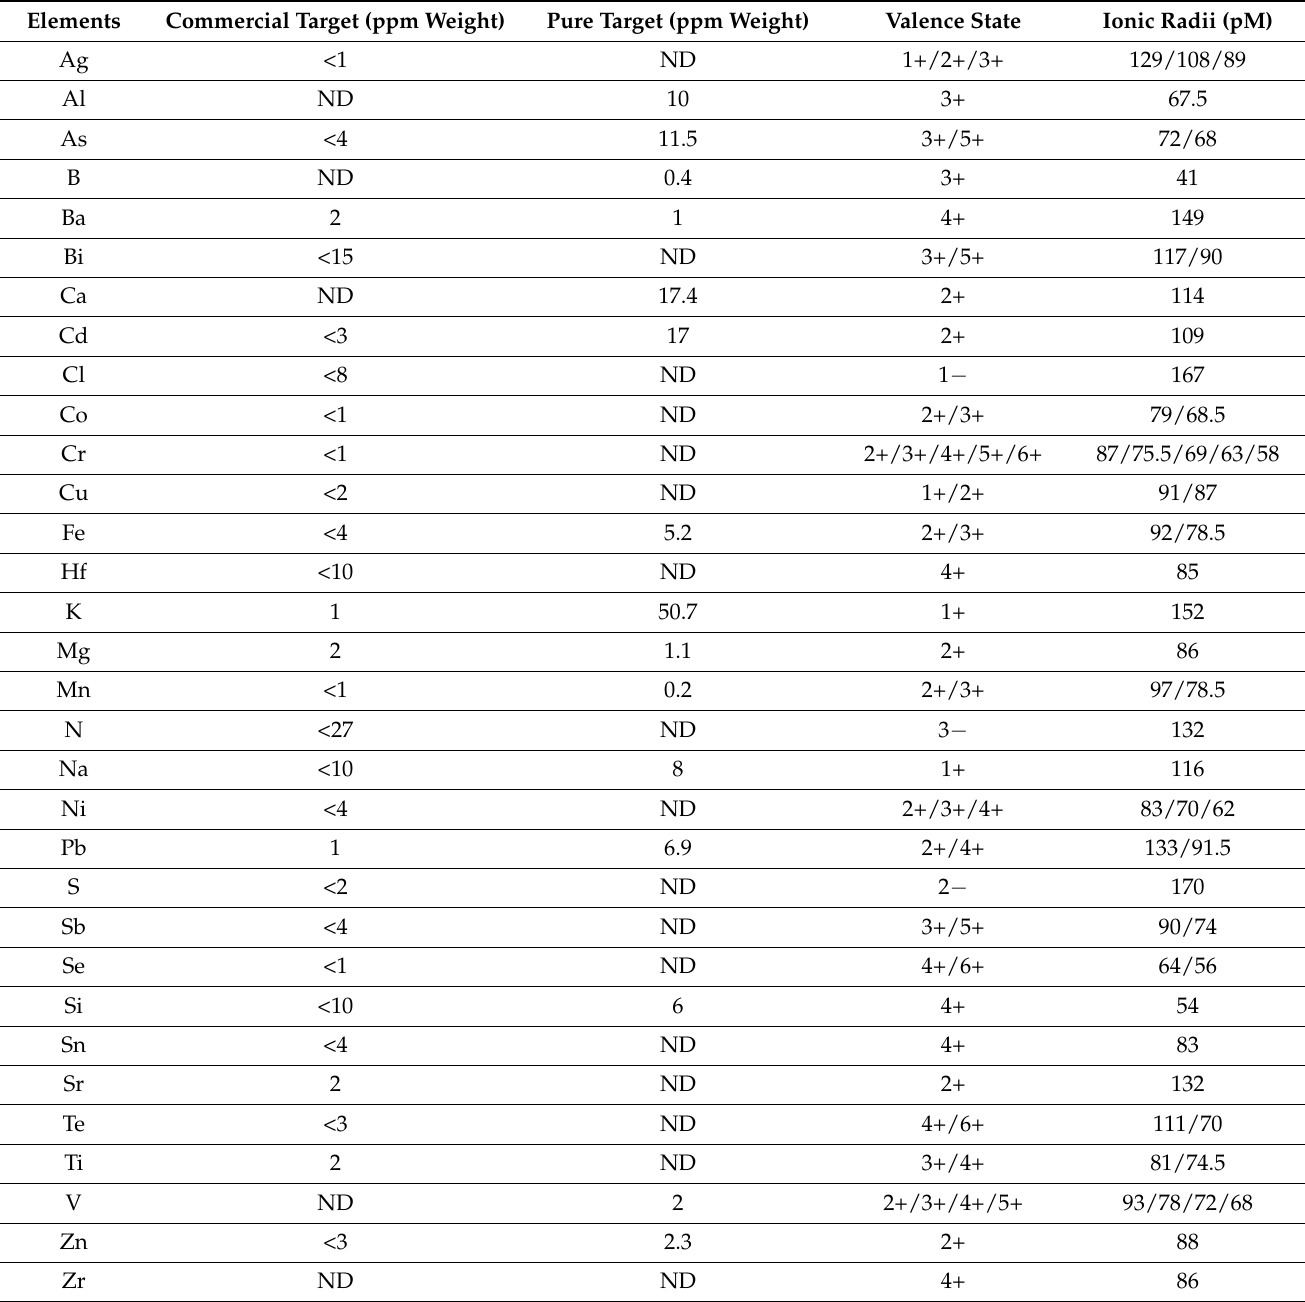
Table 3. Trace elements detected in the commercial target and in the metal oxides used as raw materials for the pure target (data from suppliers). For some elements, the quantity in ppm could be estimated. ND is for not detected or below the sensitivity limit of the equipment. The possible valance states are also given, together with the corresponding ionic radii